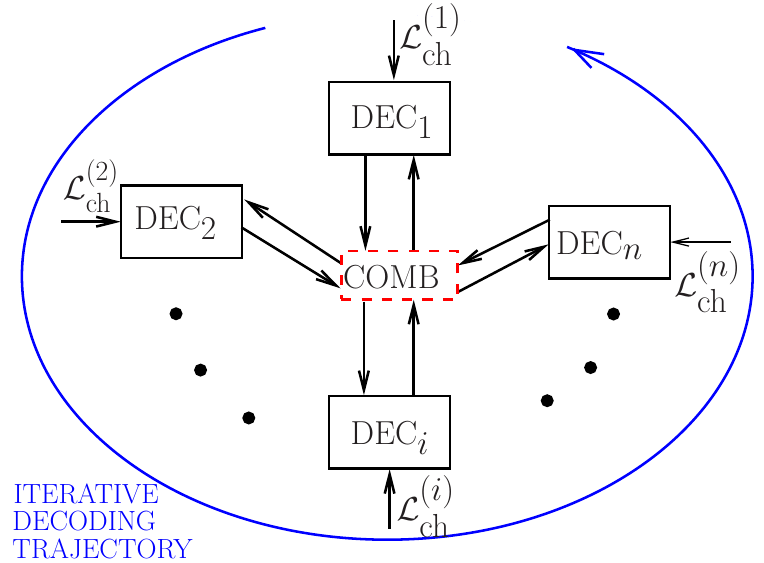
Figure 4. Iterative JCD scheme at the AP in the presence of n